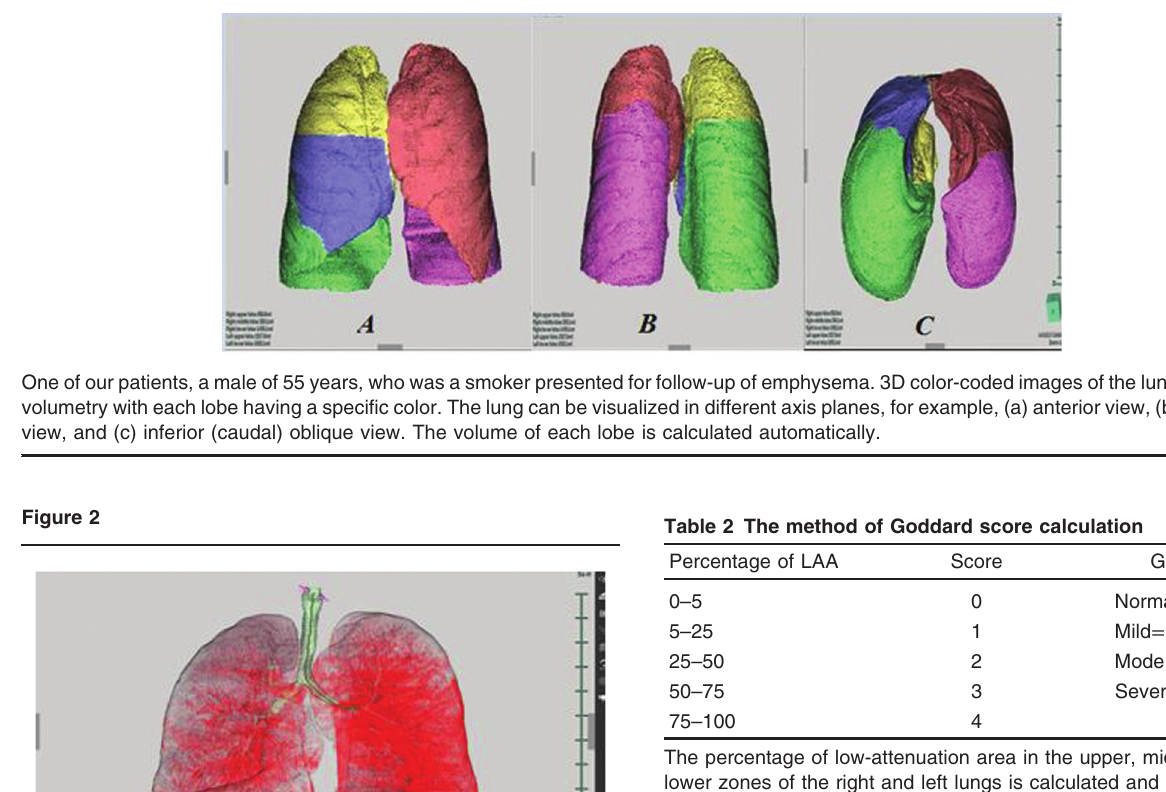
The percentage of low-attenuation area in the upper, middle, and lower zones of the right and left lungs is calculated and gives a specific score with its sum giving the final Goddard scoring. LAA, low-attenuation area.